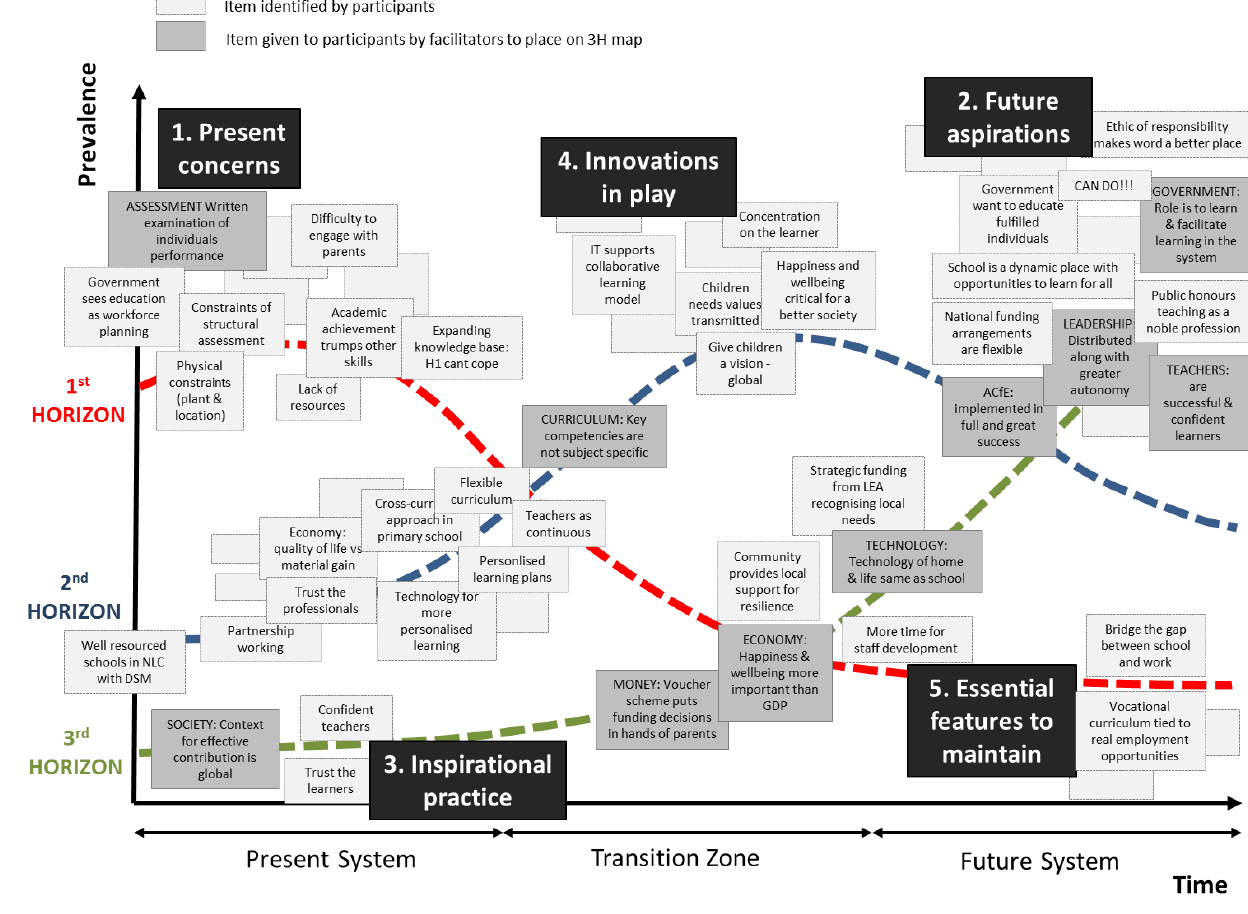
Fig. 3 . An example of the outcome of using Three Horizons as a process to structure dialogue developed through working with a local authority in Scotland to transition to the Curriculum for Excellence. The black numbered boxes represent the order in which different aspects of the Three Horizons are explored. The dark grey shaded boxes were items given to participants by the facilitators to trigger thinking about how things might change in the future. These prompted wider discussion and are represented by the lighter shaded boxes. The figure is an anonymized version with only a sample of the items